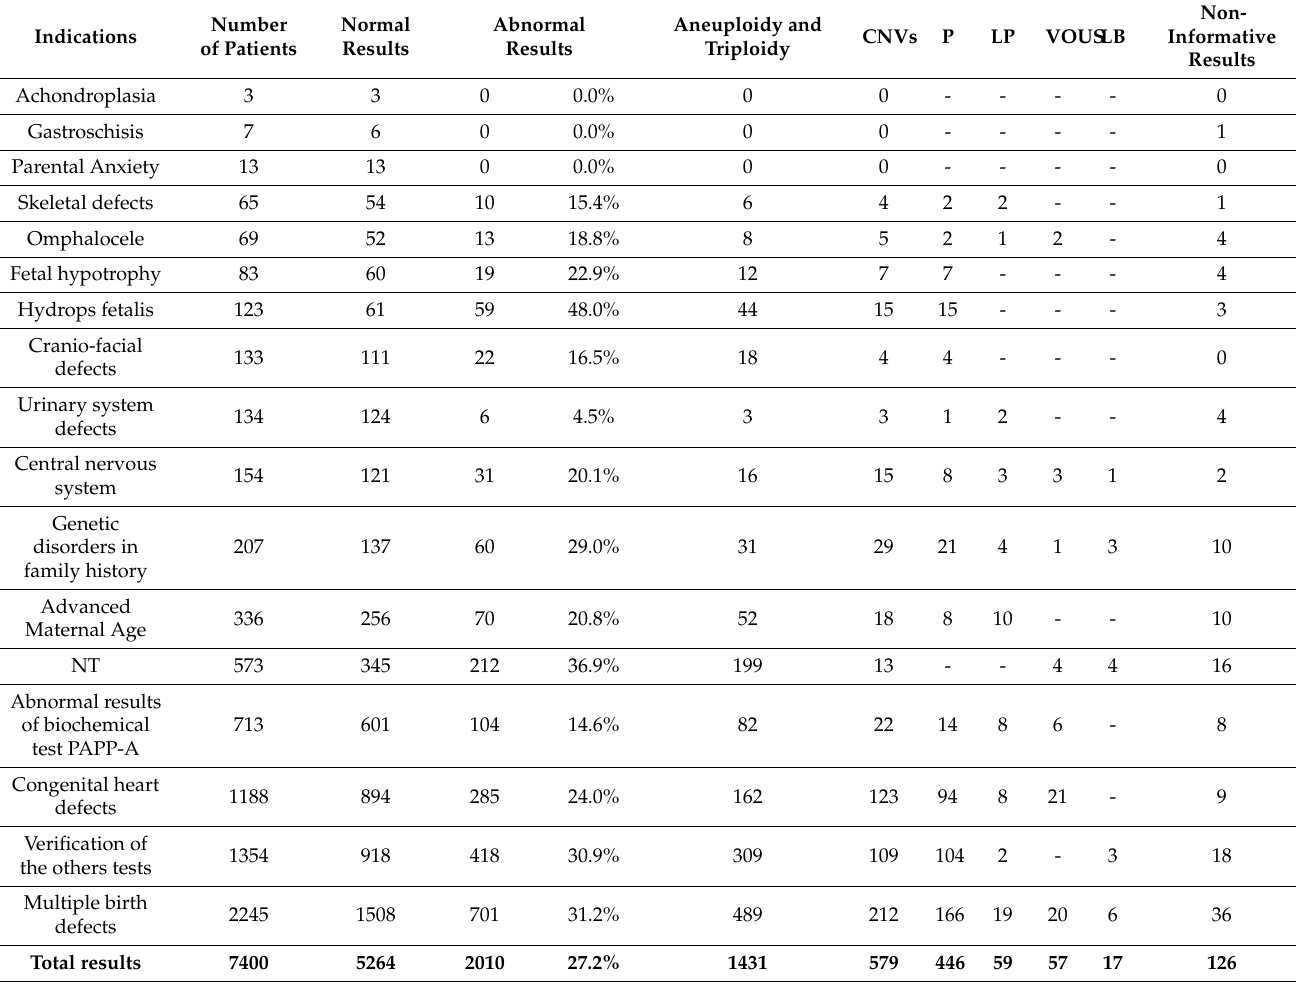
Table 2. Microarray results of 7400 samples according to reason for prenatal